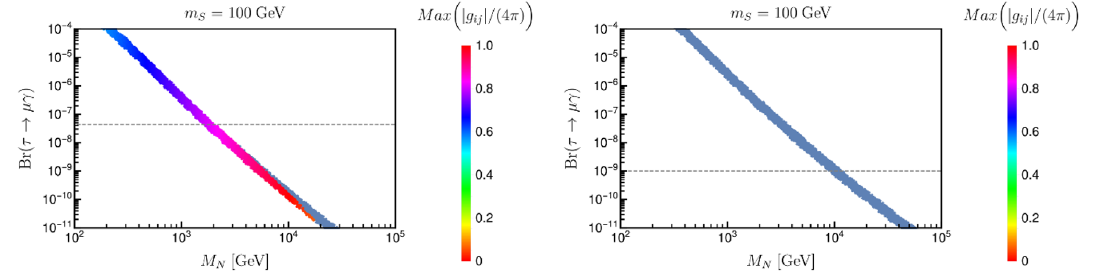
Figure 7 . Calculated values for Br( (cid:28) (cid:22)(cid:13) ) as function of the common fermion mass M N , for the ! current lower limit on m s = m s = 100 GeV. To the left, with current experimental limits; to the 1 2 right for the expected future experimental limits. The required size of the Yukawas is color-coded. Bluish-grey points mean that at least one entry in g is larger than 4 (cid:25)